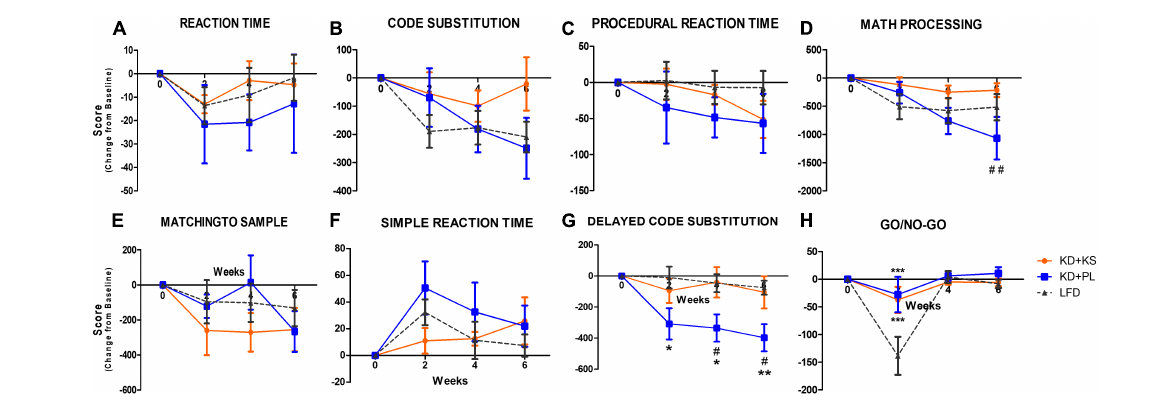
FIGURE4 Automated neuropsychological assessment measures (ANAM) results for different cognitive domains in all diet groups. Change from baseline values are used to correct for different baseline values within groups. (A) Reaction time, (B) code substitution, (C) procedural reaction time,